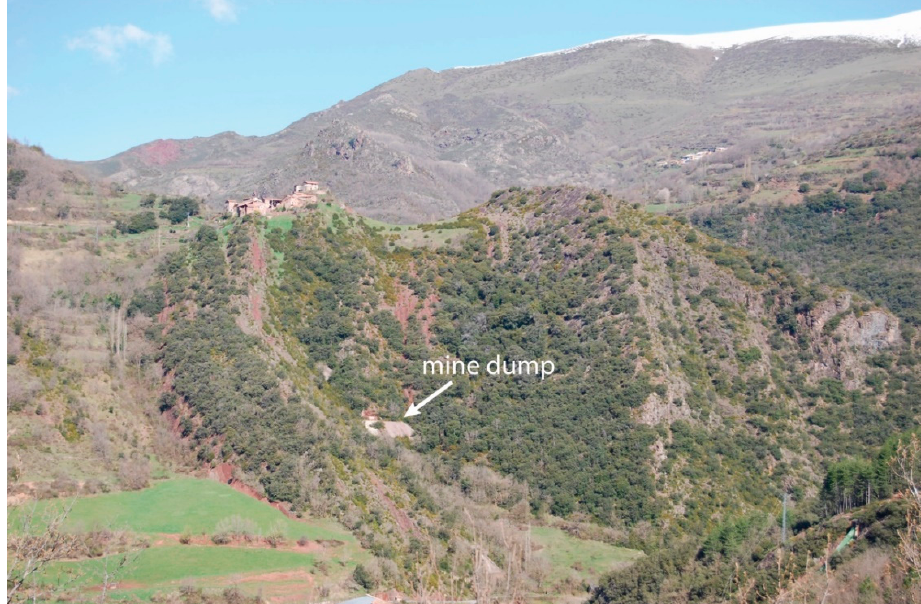
Figure 2. Image of the main Eureka mine outcrops, with Castell-estaó village at the top of the Uixer hill. Note the Buntsandstein red sandstones that host the mineralisation, dipping approximately 60° to the South (to the left of the image). The grey outcrops at the right part of the image correspond to Paleozoic rocks. The main mine dumps can be seen half-way up the mountain.